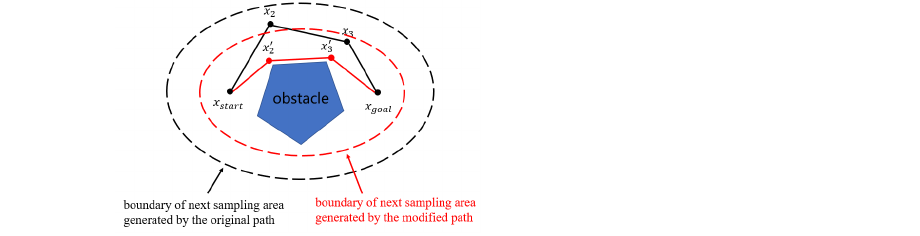
Figure 4. The boundary of sampling area determined by the modified path after stretch